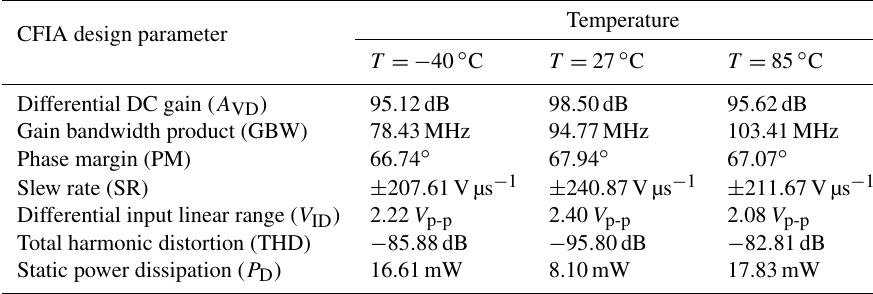
Table 4. Optimized CFIA characteristics results, V DD = 3 . 3V, V CM = 1 .